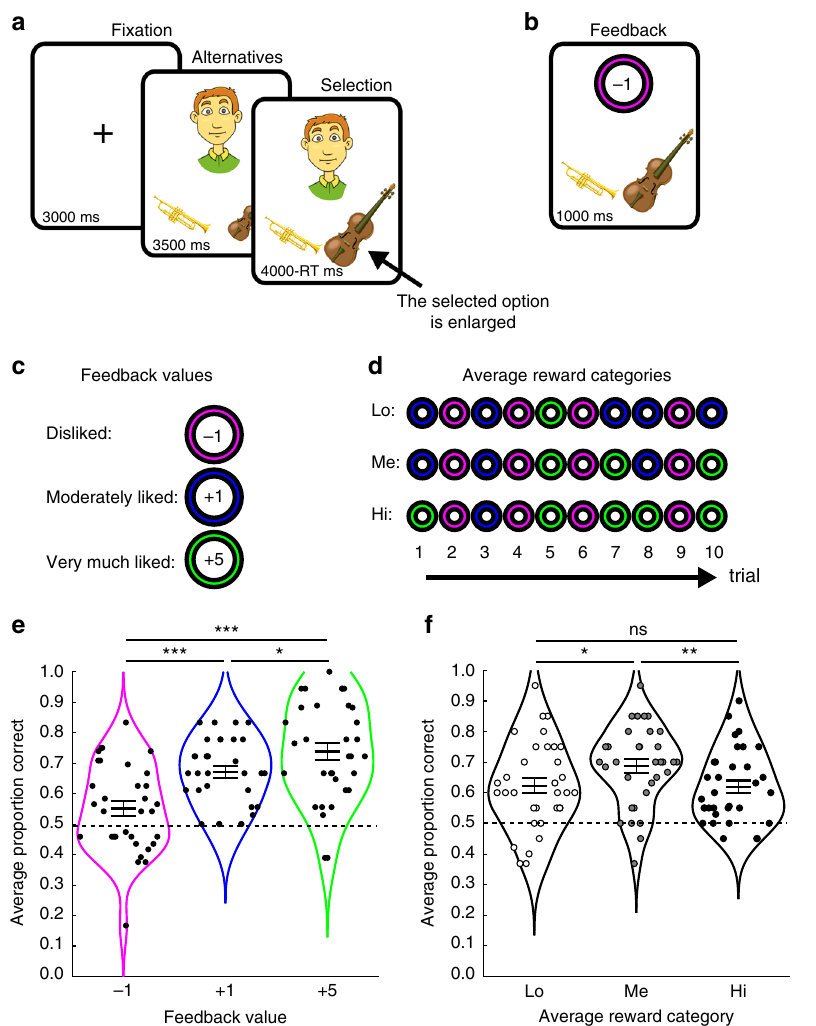
Fig. 1 Stimuli and behavioral results. a During both encoding and testing, each trial started with the presentation of a cartoon character together with two objects. During encoding trials, participants randomly selected one object and then received a feedback indicating how much the selected object was liked by the character (see b ). c During encoding, three different feedback values were presented indicating whether a selected object was disliked (magenta circle, − 1), moderately liked (blue circle, + 1), or very much liked (green circle, + 5). d Average reward was the average of ten feedback values displayed for a given character. Two characters were associated with high (Hi) average reward (one + 1, fi ve + 5s), two with medium (Me) average reward (three + 1s, three + 5s), and two with low (Lo) average reward ( fi ve + 1s and one + 5). e Memory performance (proportion correct) increased monotonically as a function of feedback value. f . Memory performance increased nonlinearly (inverted U-shape) as a function of average reward. *** p < 0.001, ** p < 0.01, * p < 0.05, ns not signi fi cant ( p > 0.05), indicates the p value for paired t- tests. Horizontal lines in f and g indicate mean ± SEM. Source data are provided as a Source Data fi le. The images used to illustrate the paradigm in a , b were obtained from https://publicdomainvectors.org/ and http://www.